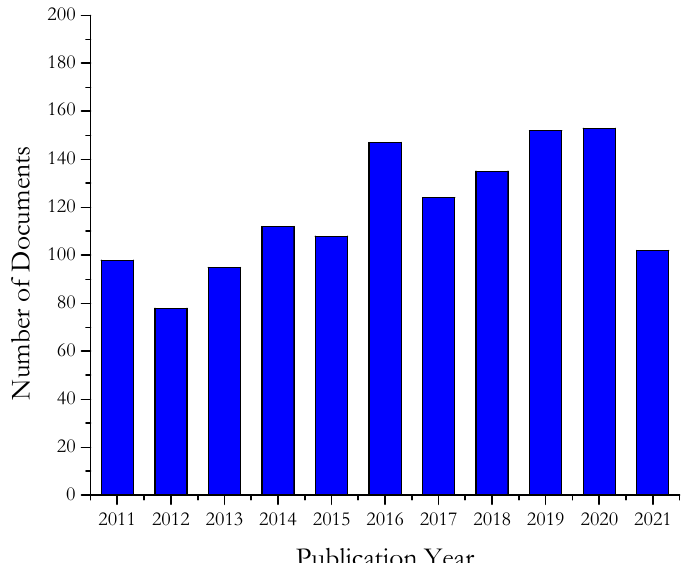
Figure 1. Papers published per year between January 2011 and June 2021 in journals, books, conference proceedings dealing with accelerated aging procedures for polymers found in the Scopus database.